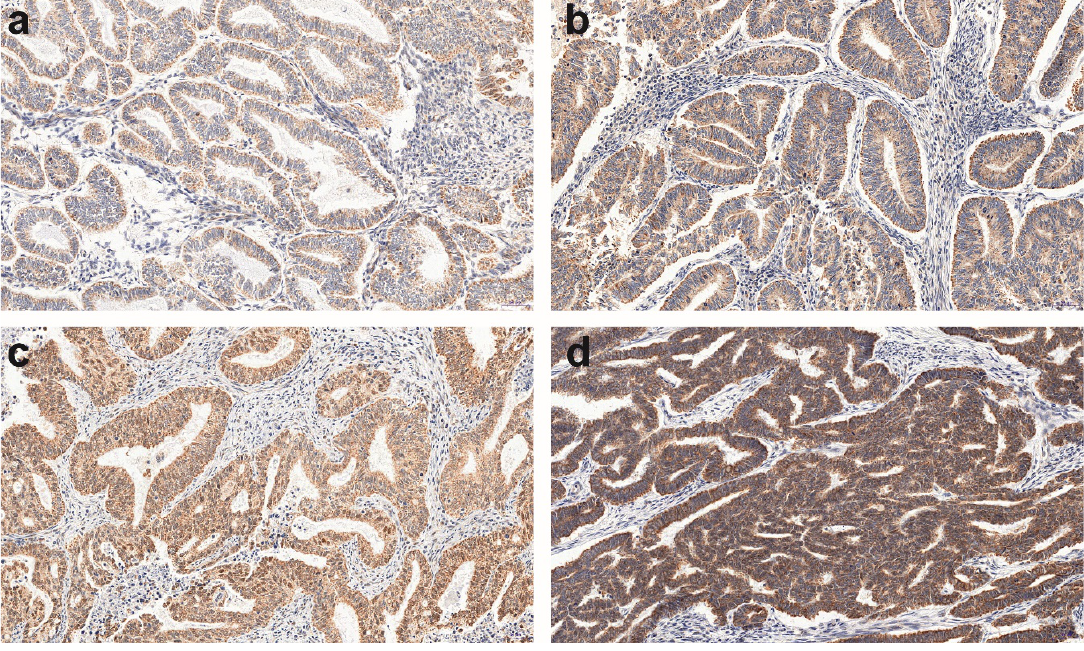
Figure 1. A representative example (20 × magnification) of the weak ( a ), moderate ( b, c ), and strong ( d ) AMHRII immunohistochemistry (IHC) reaction within endometrioid adenocarcinoma G1 ( a ) and G2 ( b, c, d ) grade. Table 1. Summary of the histopathological type of endometrial lesion, number of patients in each group, and mean ± SD, 95% confident limits of mean, quartiles Q1, Q2, Q3, minimal and maximal values of AMHRII expression.